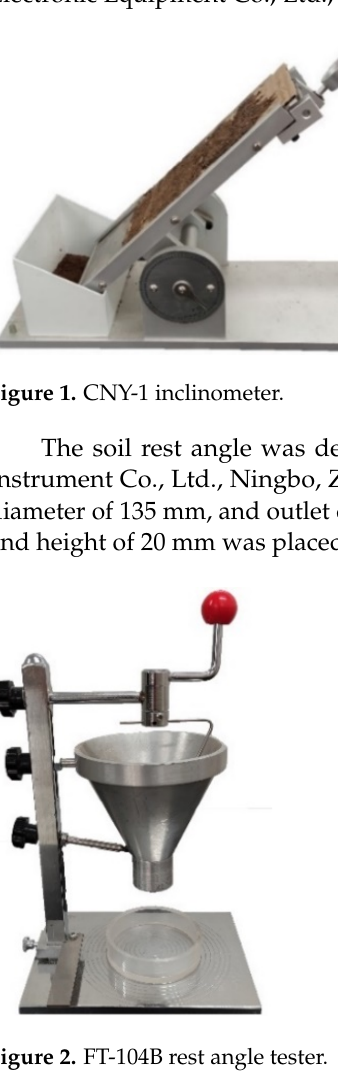
Figure 2. FT-104B rest angle tester.